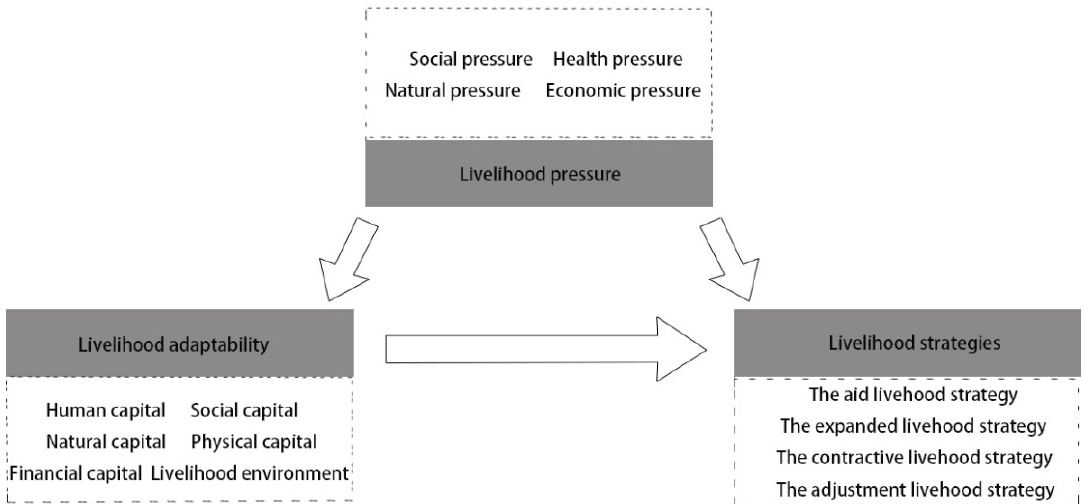
Figure 1. Research framework of livelihood adaptability of rural households in earthquake-stricken areas.